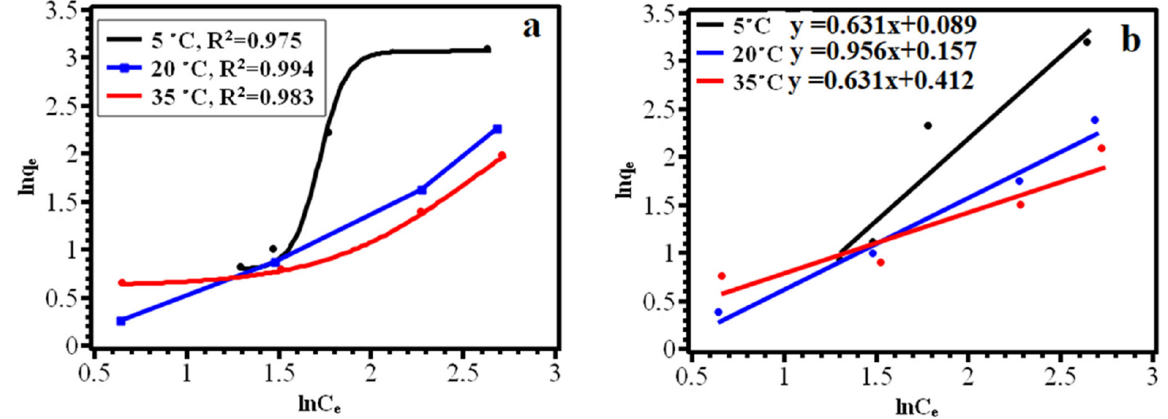
Figure 8. Freundlich isotherms of the solid-phase extraction of IC dye in non-linearized ( a ) and linearized ( b ) form. Table 3. Isotherm model constants of dyes by the nanocomposite.